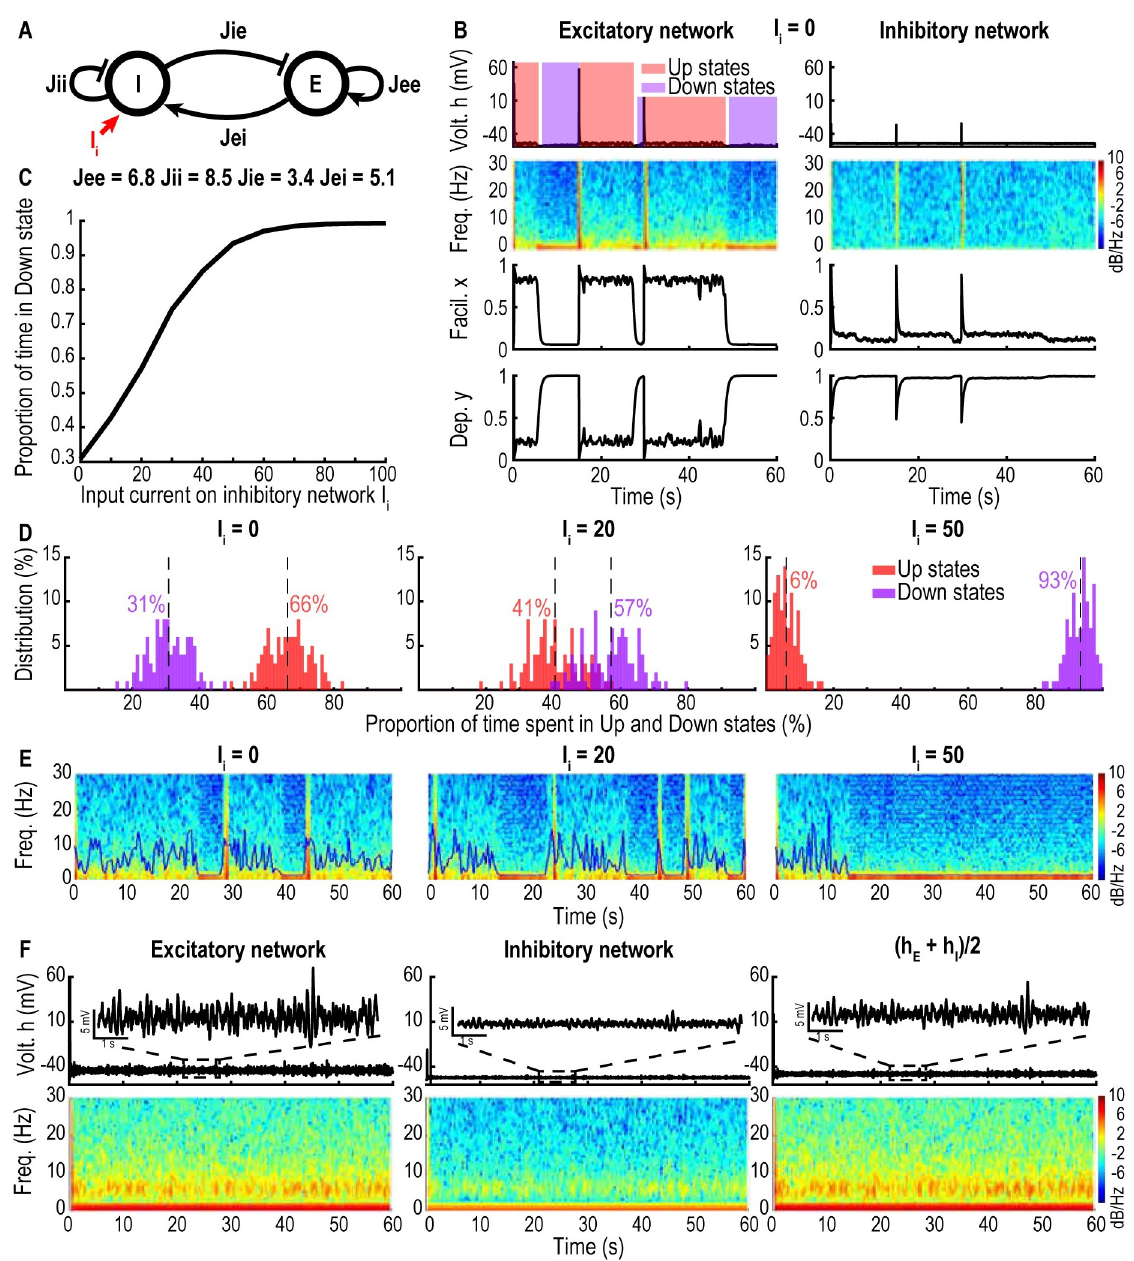
Fig 4. Excitatory-inhibitory network. A: Schematic of connectivity between the excitatory (E) and inhibitory (I) networks. B: Time series of the excitatory with AHP (left) and inhibitory (right) networks with the spectrograms of h for J = 0.5s, τ f = 0.3s and I i = 0. C: Fraction of time spent in the Down state by the excitatory network with respect to I i 2 [0, 100]. D: Distributions of the fraction of time spent in the Down (purple, resp. Up, red) state by the excitatory network for I Spectrograms (60s simulations) of h for for I = 0 (left), 20 (center) and 50 (right) with SEF 95 (blue line). F: Time series of the mean voltage h E i (upper) and spectrograms (lower) for the case where the excitatory network does not have AHP and with the timescales τ = 0.01s, τ r = 0.2s, τ f = 0.12s, showing an α